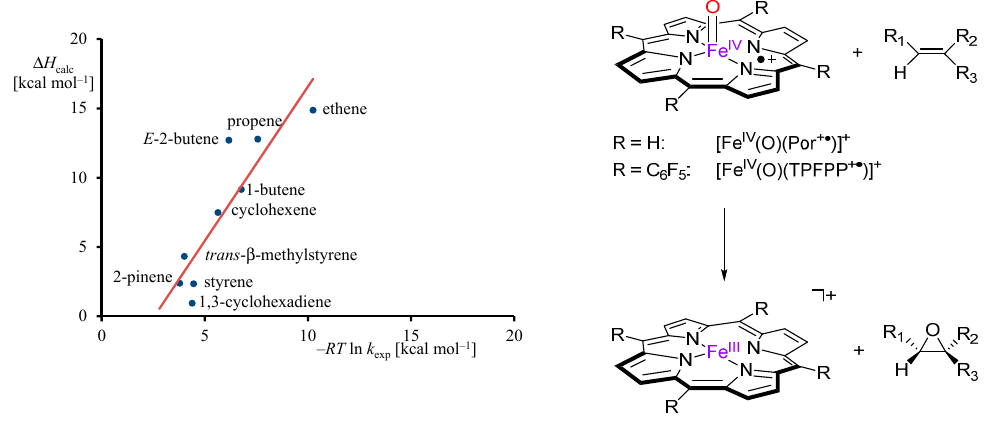
Figure 5. Correlation of experimental (FT-ICR MS) obtained rate constants versus computational barrier heights for olefin epoxidation by iron(IV)-oxo porphyrin cation radical models. Further benchmark studies on experimental versus computational determined reaction rates and free energies of activation were done on several nonheme iron(IV)-oxo systems [70–73]. In